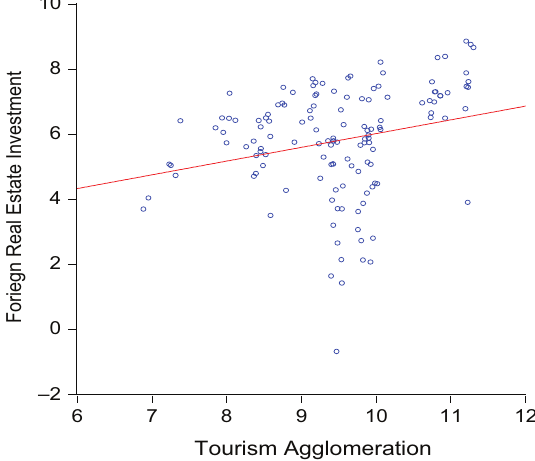
figure 2. The association between tourism agglomeration (ln of number of people - 000 people in) and foreign real estate investment (ln of millions of US